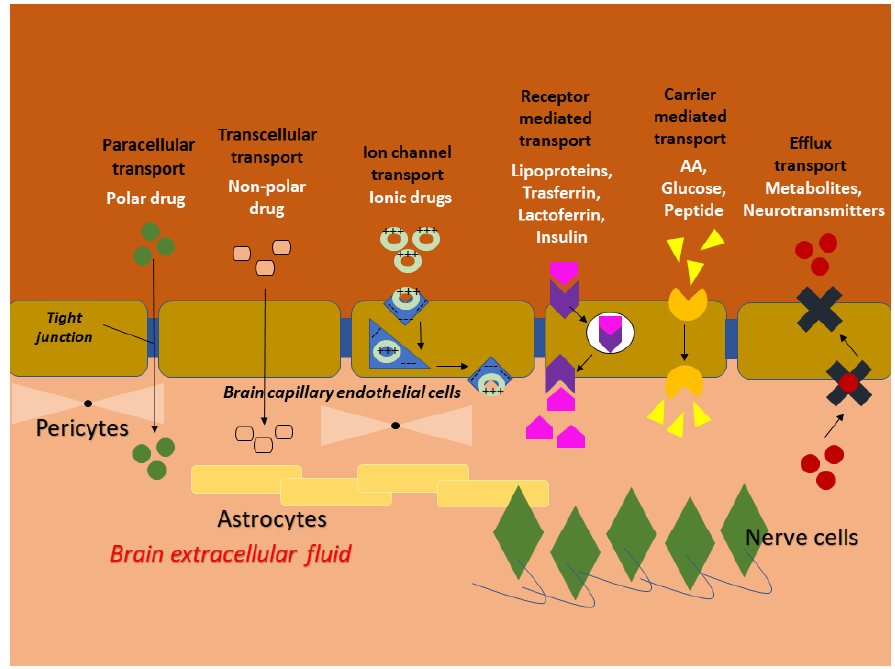
Figure 3. Schematic representation of drug transport across the BBB via different mechanisms, including paracellular and transcellular transport, receptor-mediated transport, ion channel transport of surface charged molecules, carrier-mediated transport of amino acids, glucose, larger proteins, and peptides, and the efflux transport that regulates the outflow of metabolites, drugs, toxins and neurotransmitters (Adapted from [118], NCBI,